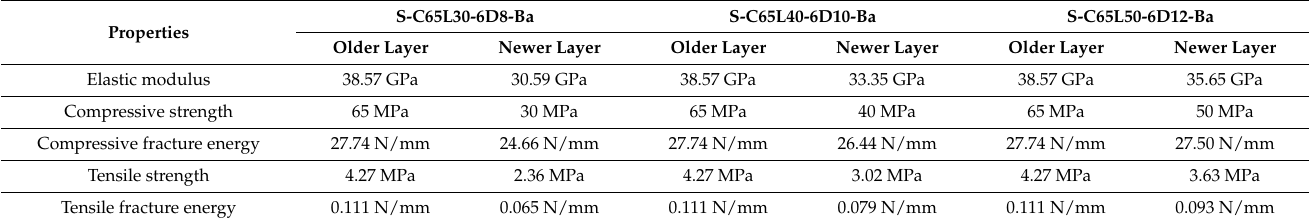
Table 1. Concrete characteristics for numerical models.